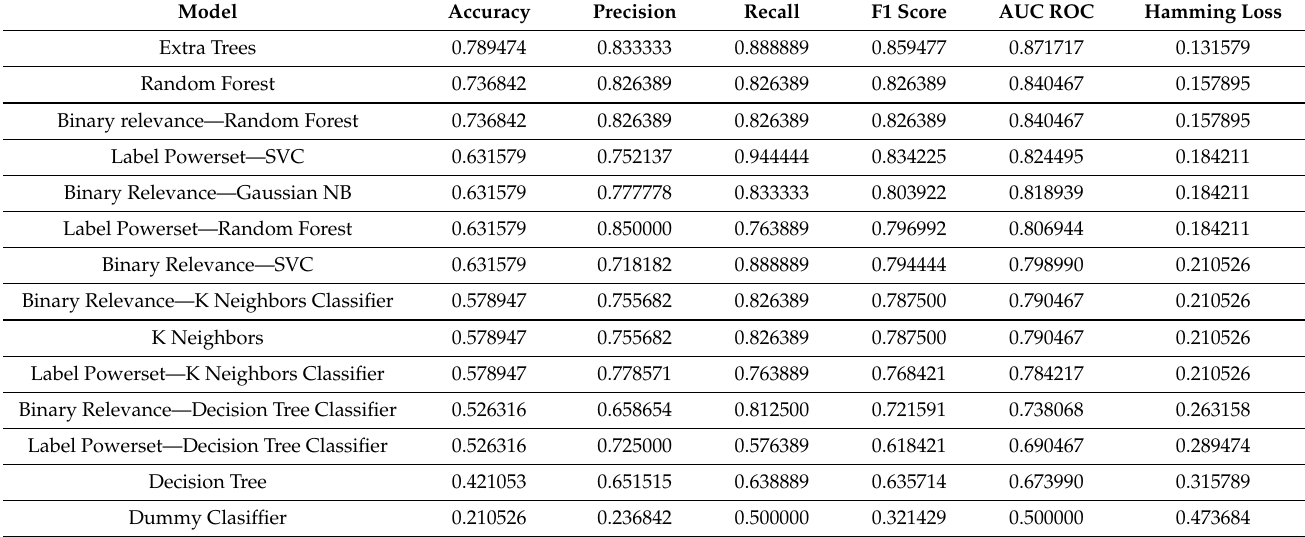
Table 3. Performance metrics for all models evaluated, sorted by the AUC-ROC